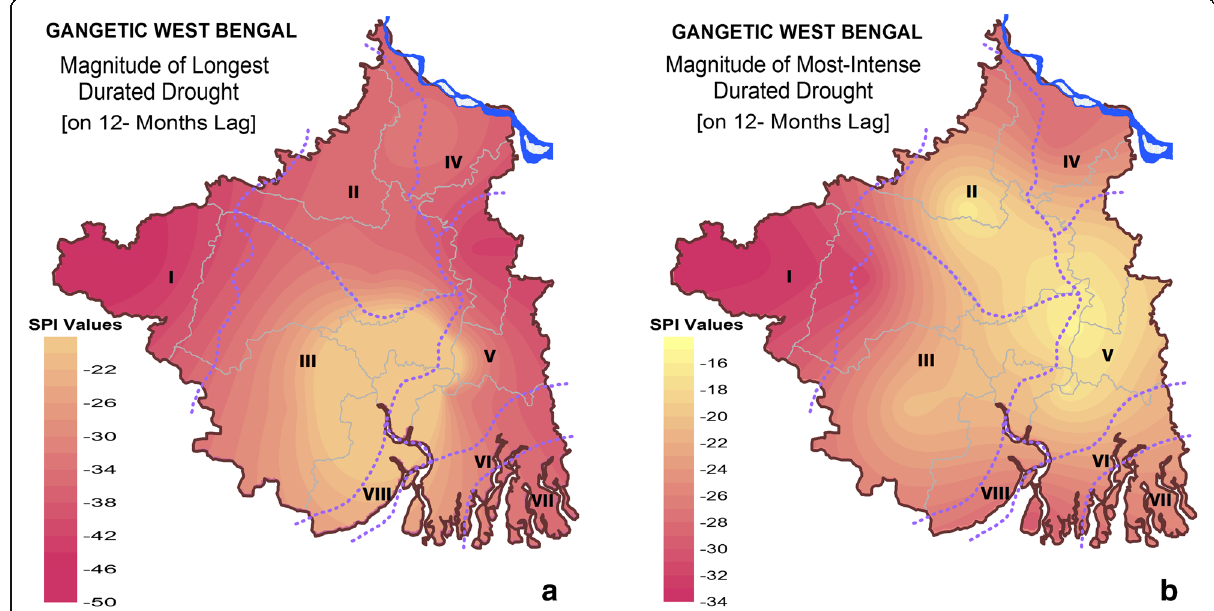
Fig. 9 Drought magnitude for ( a ) longest and ( b ) most most-intense durated draught on 12-months time